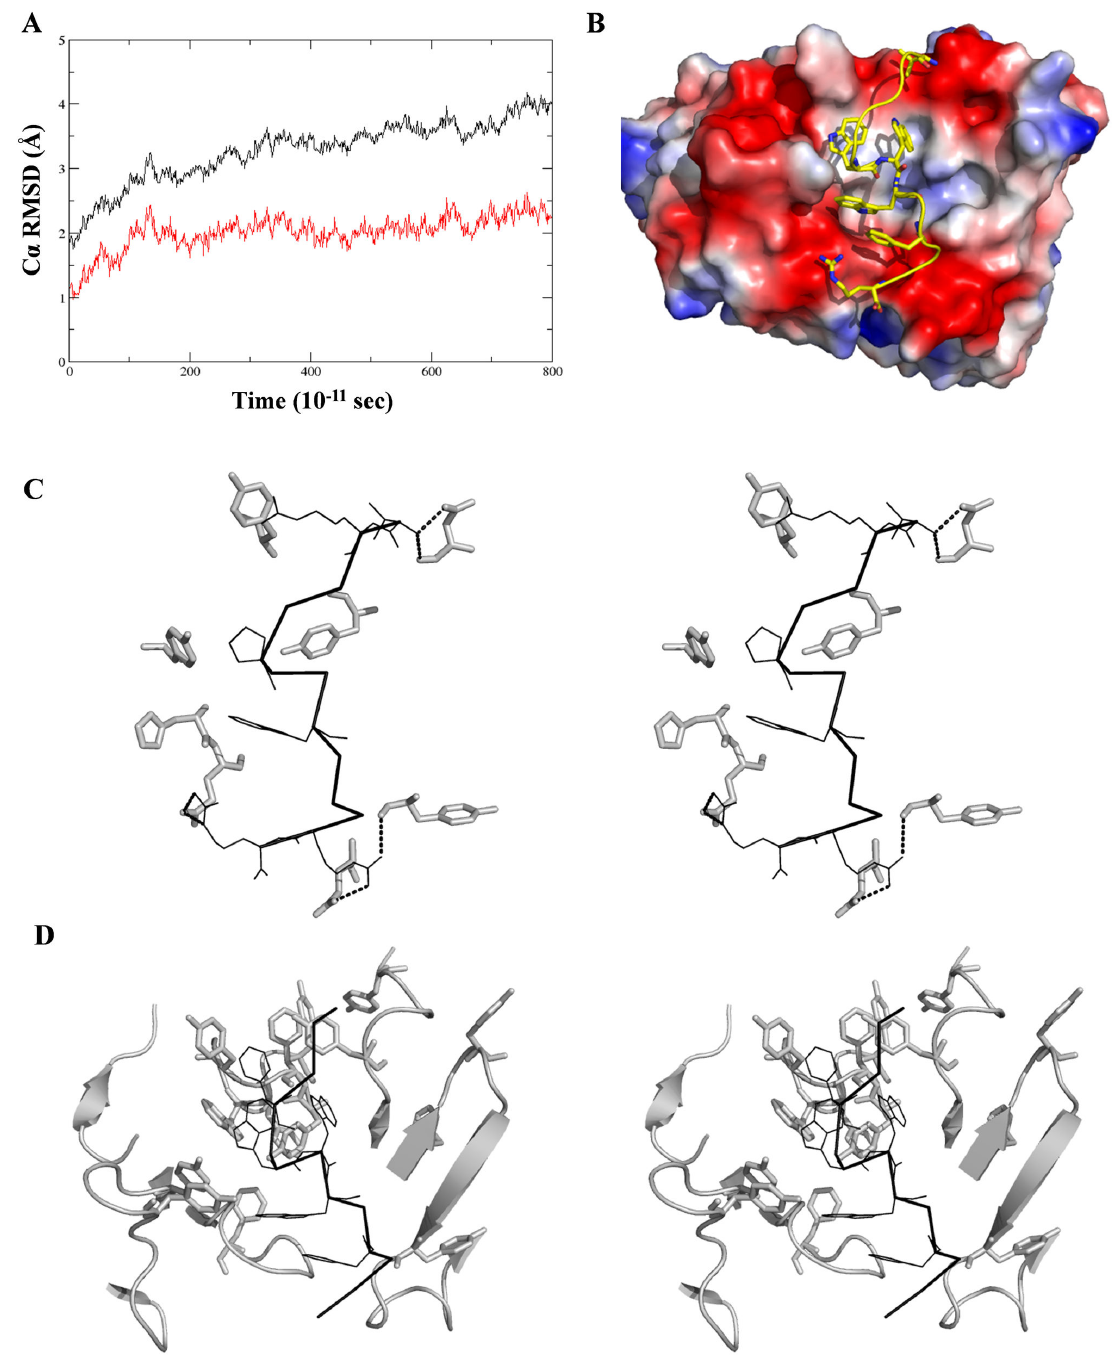
Figure 5. In- silico binding analysis of tritrpticin to mAb 6C6D7. A. RMSDs of Cα atoms of the CDRs and tritrpticin (black) and that of whole 6C6D7 Fv and tritrpticin (red) during the 8 ns MD simulation. The averaged structure from last 6 ns run was energy minimized and used for further analysis. B. Surface view of peptide – mAb interaction, shaded according to electrostatic potential (blue to red indicating positive to negative, respectively) showing complementarity of shape and charge. Also can be seen the three tryptophans buried in the hydrophobic cavity shielded from solvent. C. Stereoscopic representation of binding pocket containing bound peptide. Interacting residues for peptide are shown as ribbon and for Fv as sticks. The polar interactions obtained by PISA are shown as dotted lines. D. Stereo view of the binding pocket showing preponderance of aromatic residues both in paratope (ribbon) and epitope (sticks). doi: 10.1371/journal.pone.0075582.g005 PLOS ONE |